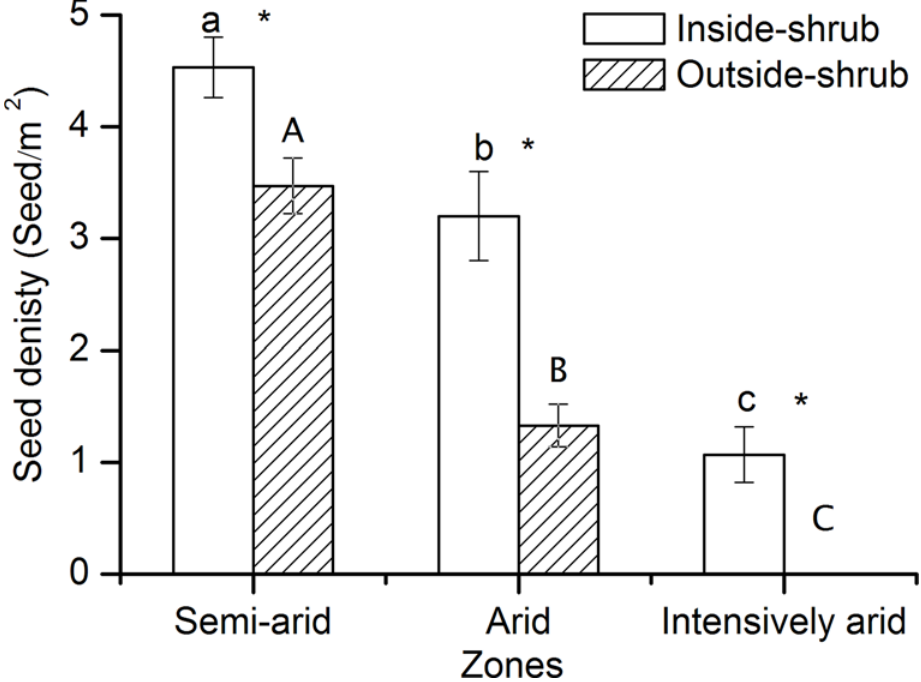
Fig 2. Seed densities inside and outside shrub canopies of C . stenophylla in the semi-arid, arid and intensively arid zones (mean ± SE, n = 3). For variables in the same category, different letters (inside- shrub: lowercase; outside-shrub: uppercase) indicate significant differences in the means between zones (Tukey HSD tests, P < 0.05). Within each zone, asterisks indicate significant differences in the means between inside-shrub and outside-shrub (t-test, P <